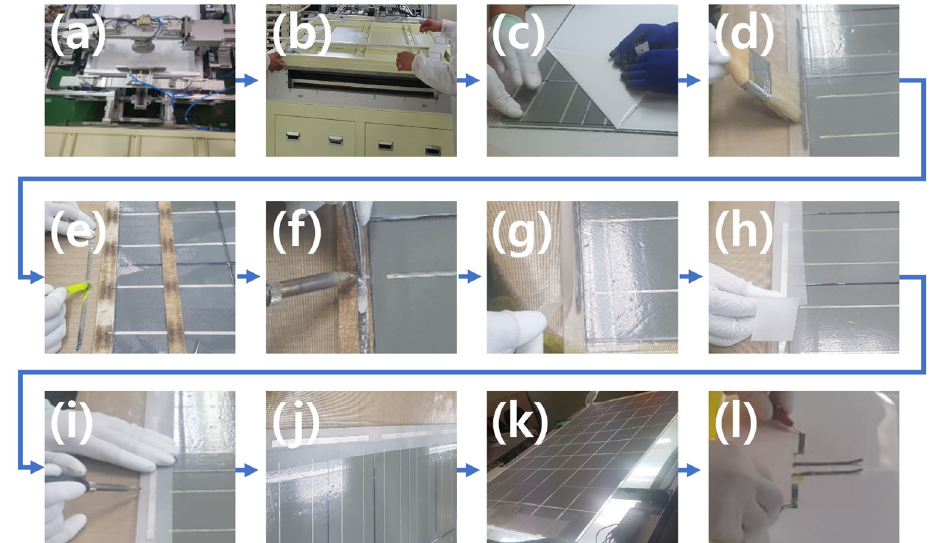
Figure 4. RSB hotspot module recovery process diagram using factory recovery technology. ( a )